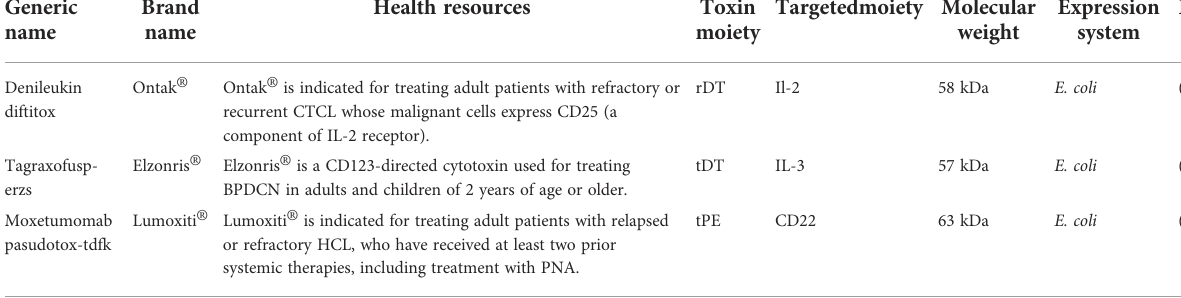
TABLE 1 The list of FDA-approved bacterial-derived immunotoxins with anti-cancer properties. Generic